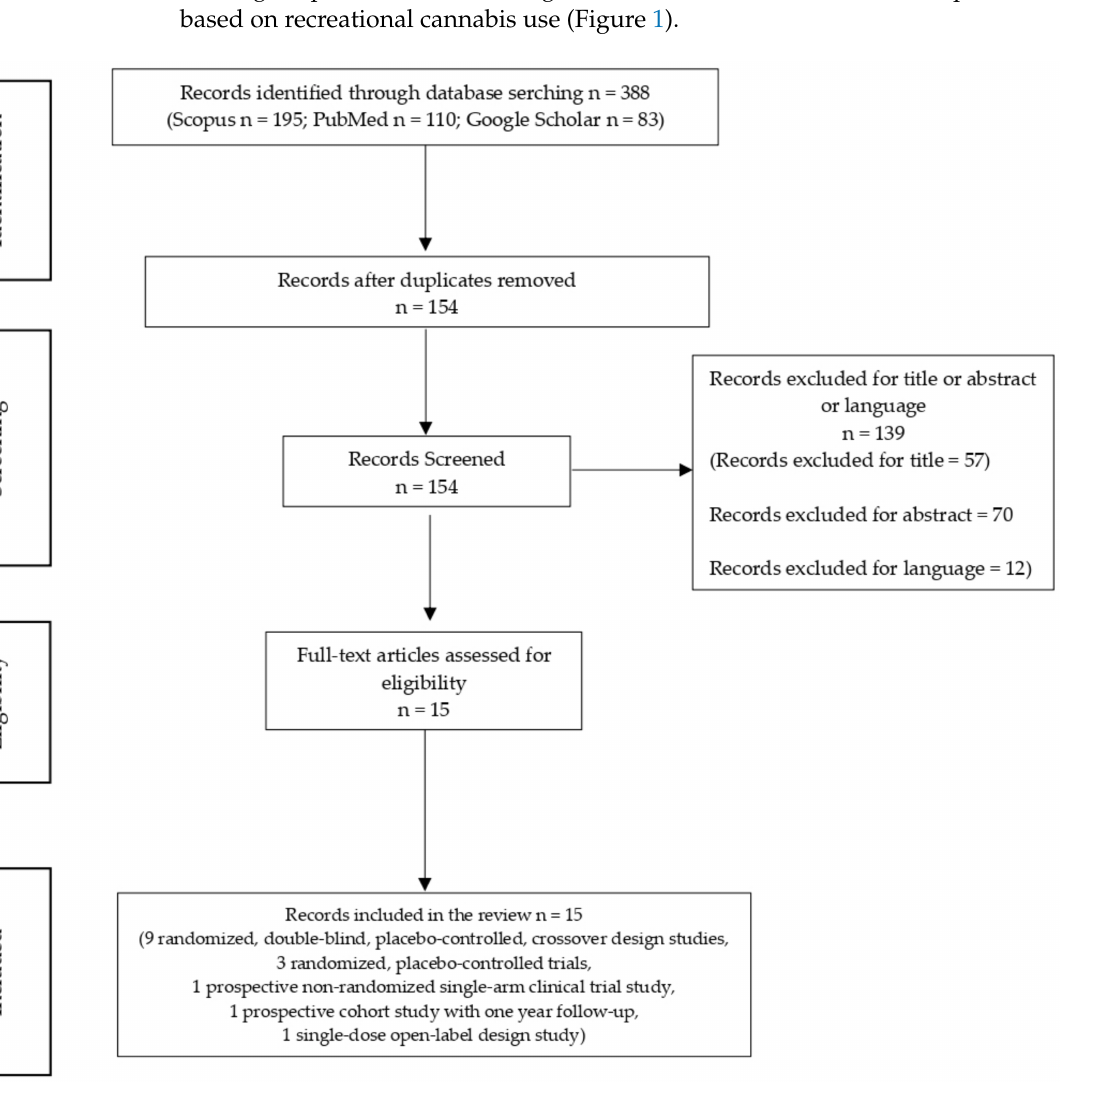
Figure 1. Flow chart of total records identified through database searching ( n =